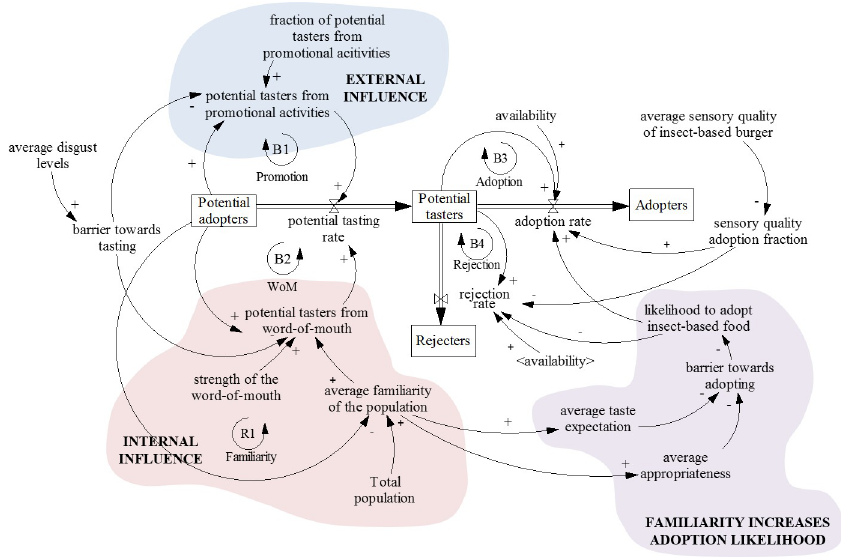
Fig 2. Stock and flow diagram of insect-based food adoption in the Netherlands. The rate with which “Potential adopters” become “Potential tasters” of insect-based food depends on external influence and internal influence on “Potential adopters”. The rate with which “Potential tasters” become “Adopters” or “Rejecters” depends on their familiarity with insect-based food, which affects adoption likelihood, and average sensory quality of insect- based burger. The running model is in S1 Dataset. ( positive causal influence–other things being equal, an increase in variable A causes an increase in variable B, or a decrease in variable A causes a decrease in variable B; negative causal influence–other things being equal, an increase in variable A causes a decrease in variable B, or a decrease in variable A causes an increase in variable B. Meaning of variables in < > : the variable is copied to avoid decluttering the image with arrows and it is defined elsewhere in the model. balancing feedback loop, reinforcing feedback loop).